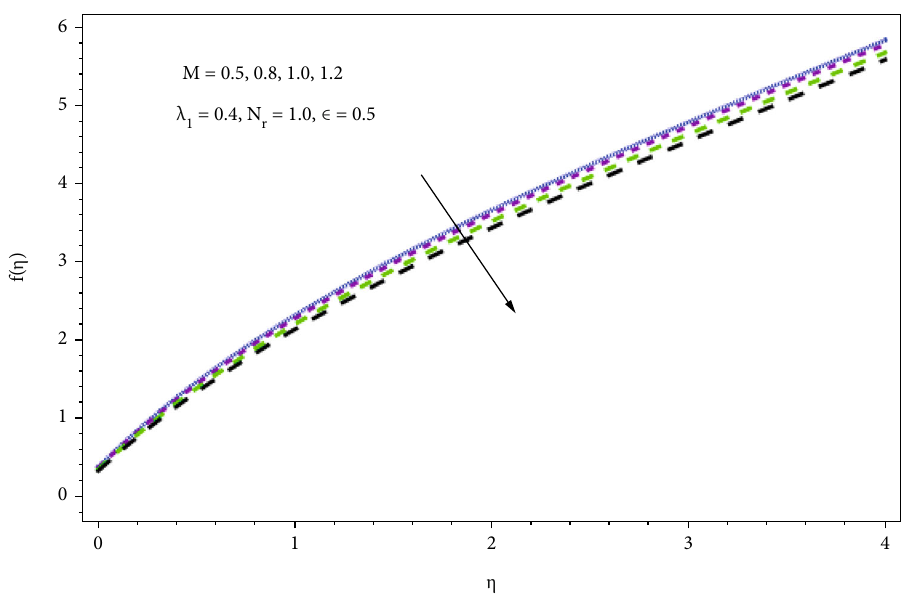
Figure 2: Illustration of the e ff ect of M on f ′ ð η Þ